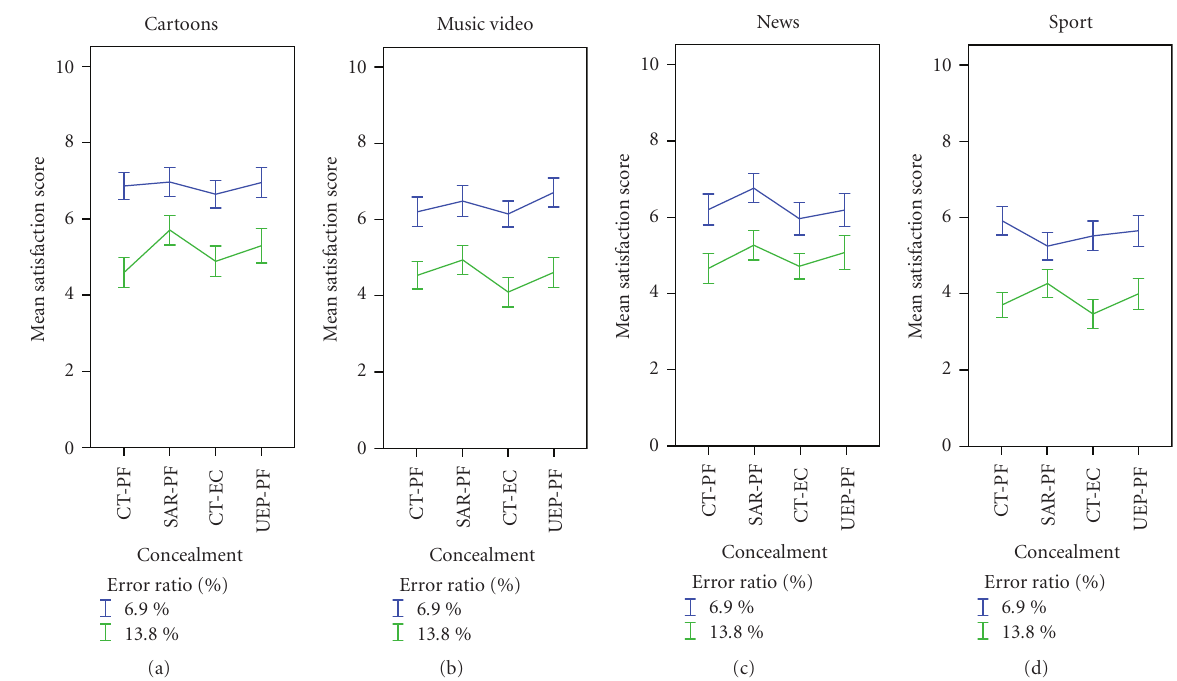
Figure 9: Retrospective satisfaction of di ff erent error rates and concealment methods for all contents. Error bars show 95% CI of mean.